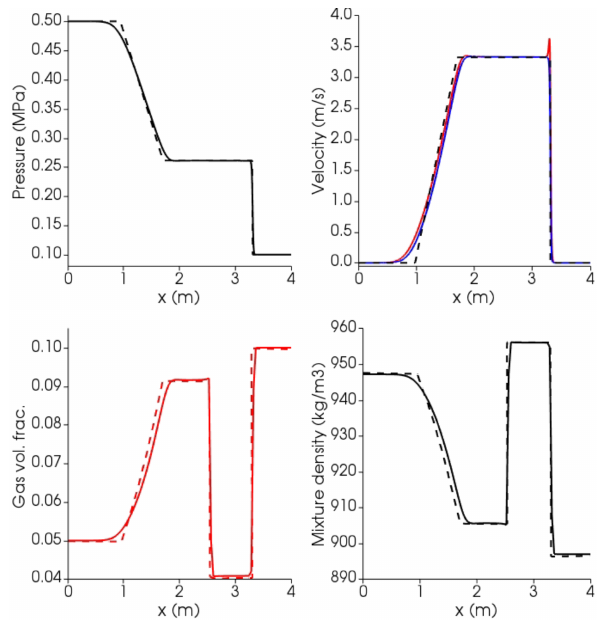
Figure 9. Results at time t = 0 . 015s for the air–water shock tube using the SPWAT EOS. Solid lines: OpenFOAM; dashed lines: analytical solution (Stadtke, 2006); black lines: mixture; blue lines: liquid (water); red lines: gas (air). Mixture density is cal- culated a posteriori as ρ mix = α g ρ g + ( 1 − α g )ρ l , where l is liq- uid and g is gas. At time 0, the interface dividing the high- pressure (left, l) from low-pressure (right, r) zone is placed at 2.5m. Initial conditions: P l = 0 . 5MPa, P r = 0 . 1MPa, and T l = T r = 300K for both phases; gas volume fraction: α l = 0 . 05, α r = 0 . 1, and U l = U r = 0 for both phases. Isobaric heat capacities of gas air and liquid water are Cp g = 1004 . 5Jkg − 1 K − 1 and Cp l = 4195Jkg − 1 K − 1 , respectively (https://webbook.nist.gov/, last ac- cess: 27 April 2022). Prandtl numbers of air and water are 0.7 and 2.289, respectively, corresponding to thermal conductivities of 0.02 and 0.67WK − 1 m − 1 (https://webbook.nist.gov/, last access: 27 April